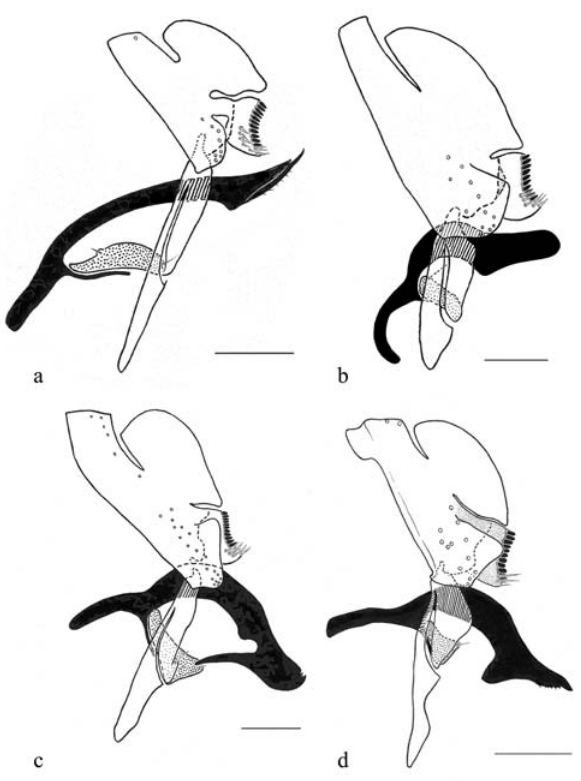
Figure 7 - Male terminalia (aedeagus + aedeagal apodeme are highlighted in black, and paraphysis is highlighted with dots), left lateral view, of: a. Drosophila aldrichi Patterson, in Patterson & Crow, 1940; specimen (n. 24) from Mexico (strain 1781.4 [University of Texas]), or (n.22) from Puerto Triunfo, El Salvador, (strain H52.12 [University of Texas]). b. Drosophila buzzatii Patterson & Wheeler, 1942; specimen (n. 28) from Corumbá, State of Mato Grosso do Sul, Brazil (strain 15.29 [University of Texas]). c. Drosophila hydei Sturtevant, 1921; locality unknown. d. Drosophila mercatorum Patterson & Wheeler, 1942; specimen from Tijuca, Rio de Janeiro City?, State of Rio de Janeiro, Brazil. Scale bars = 0.1